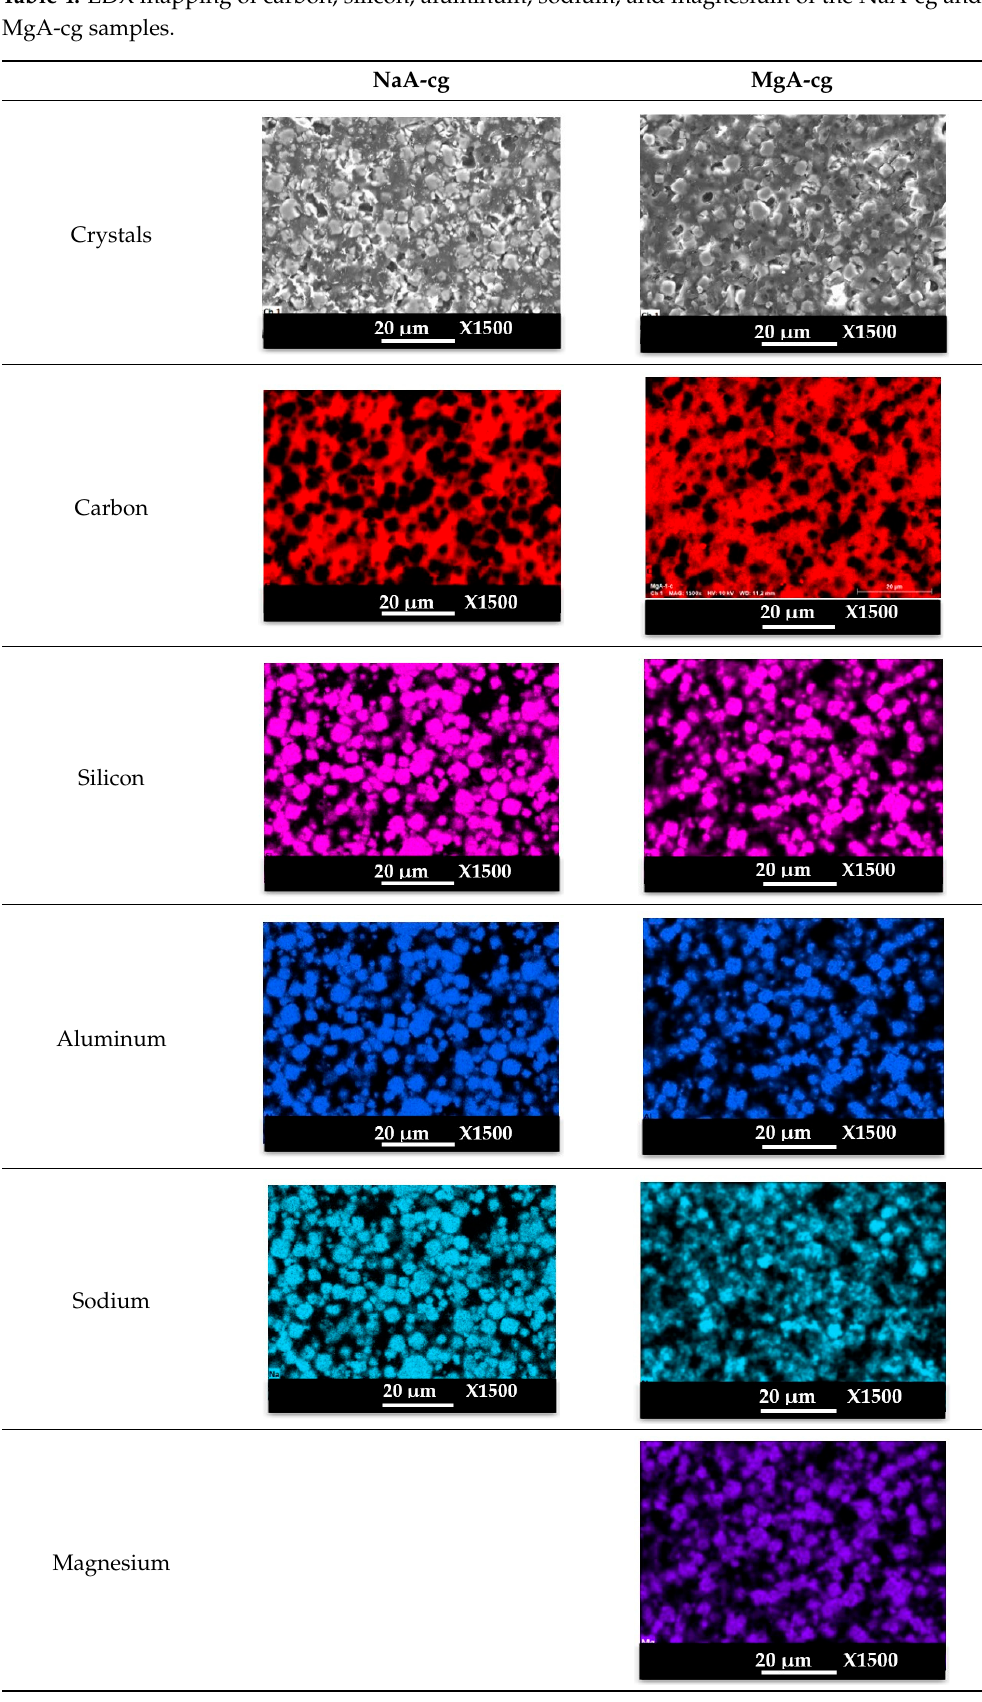
Table 5. EDX mapping of carbon, silicon, aluminum, sodium, and magnesium of the NaA-cmp and MgA-cmp (side view) samples.